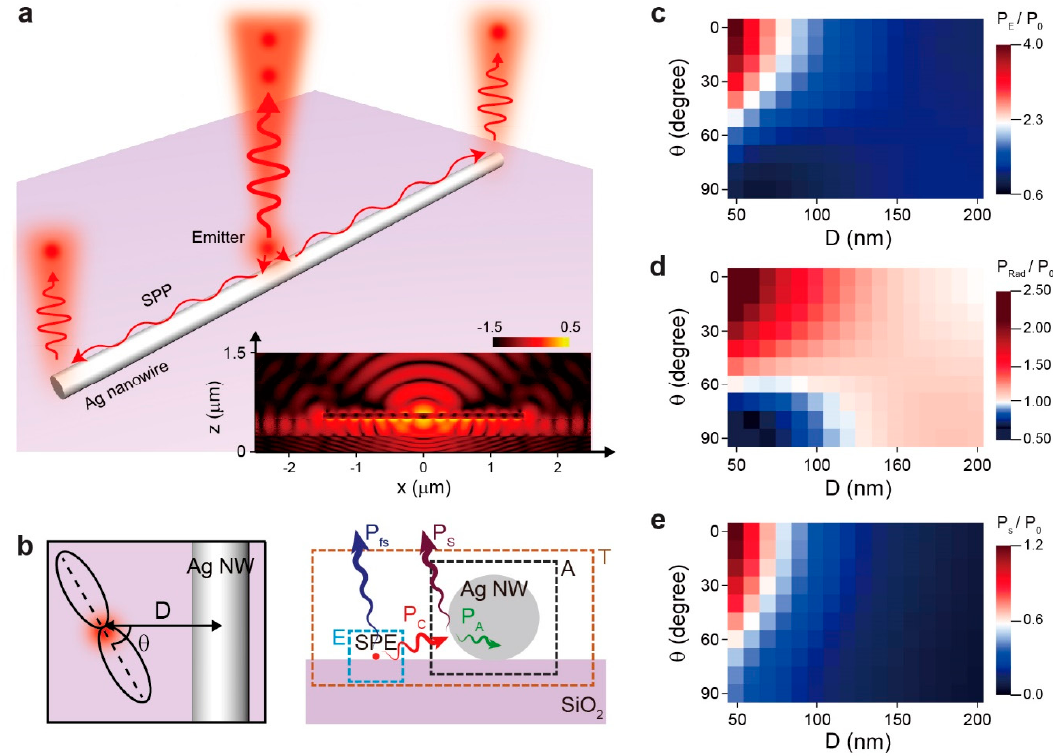
Figure 1. Single-photon emitter coupled to a Ag nanowire and simulation results. ( a ) Schematic illustration. The inset shows a cross-sectional view of the calculated electrical field intensity distribution. ( b ) The schematic on the left shows the distance (D) between the emitter, the Ag nanowire, and the polarization direction ( θ ) of the emitter. The schematic on the right shows the closed surfaces used to calculate the power emitted via various channels. P E , total power from the dipole emitter; P Rad , total radiative power; P fs , direct radiative power from emitter to free space; P c , power transferred to nanowire; P A , nonradiative power; P S , power scattered by nanowire. ( c–e ) Calculated 2D maps of the total power enhancement ( c ), radiative power enhancement ( d ), and scattered power enhancement ( e ), as functions of D and θ . The θ varies from 0 (normal to the nanowire) to 90° (parallel to the nanowire). D varies from 50 to 200 nm.